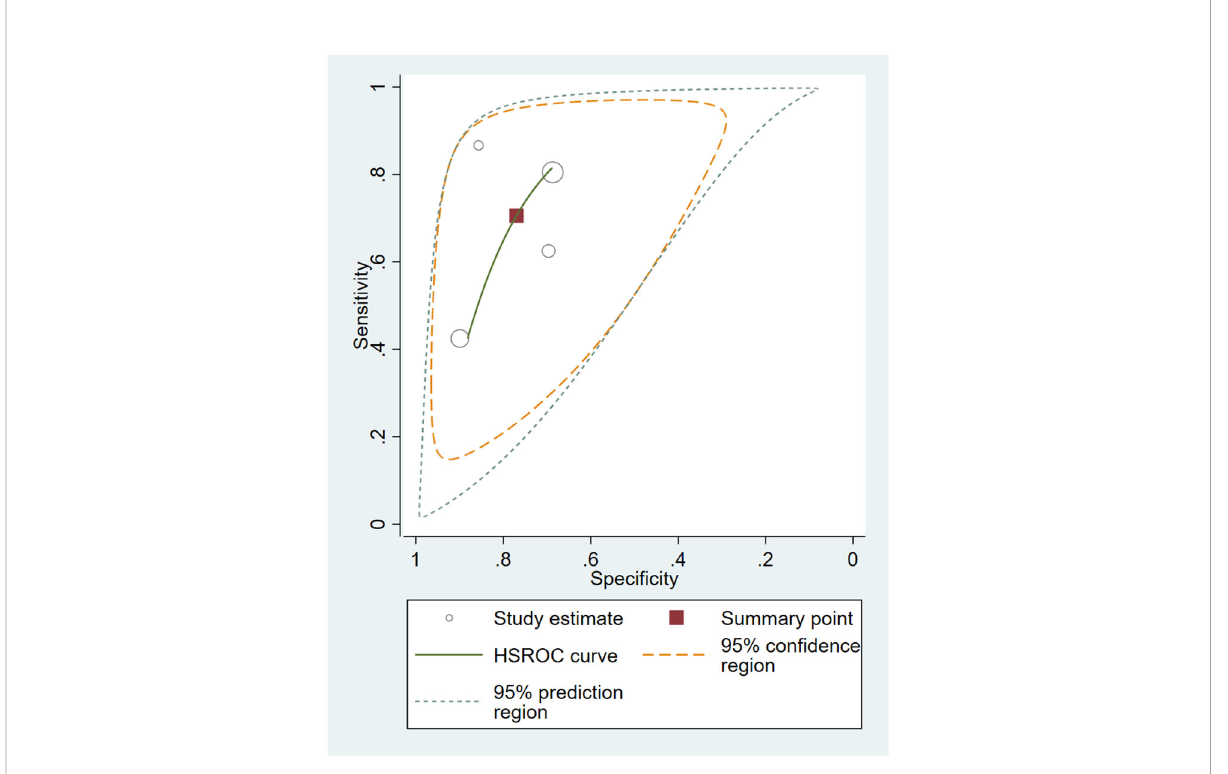
FIGURE 6 Hierarchical summary receiver operating characteristic (HSROC) curves for four